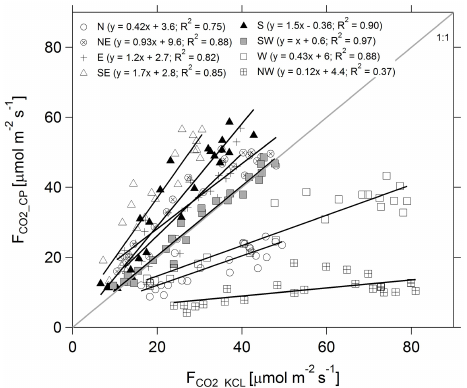
Figure 5. Comparison between average diurnal profiles of CO 2 fluxes measured at the BT tower (190ma.g.l.) and at the KCL site (50ma.g.l.) in the period 15 September 2011–31 December 2013, separated into eight wind-direction sectors based on the wind direc- tion observed at BT